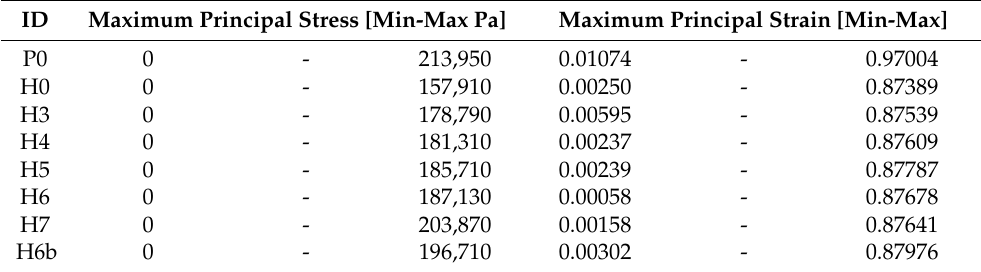
Table 3. Ranges of maximum principal stress and maximum principal